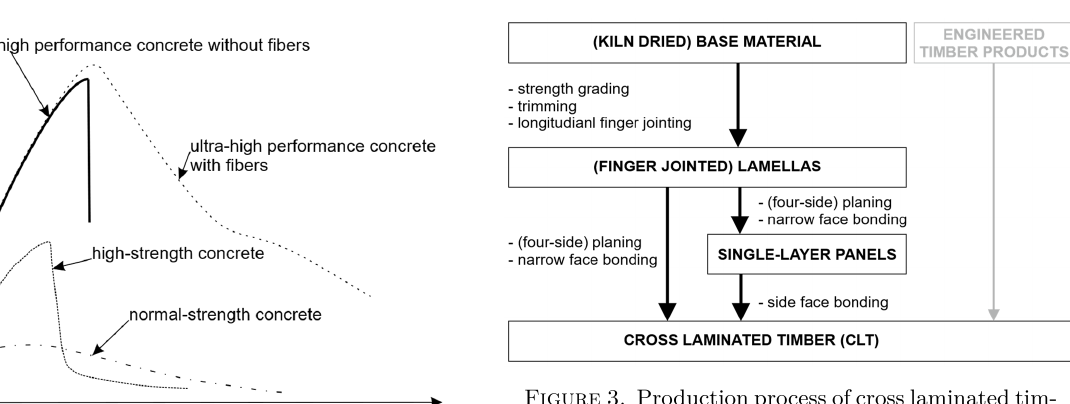
Figure 3. Production process of cross laminated tim- ber according to [9].